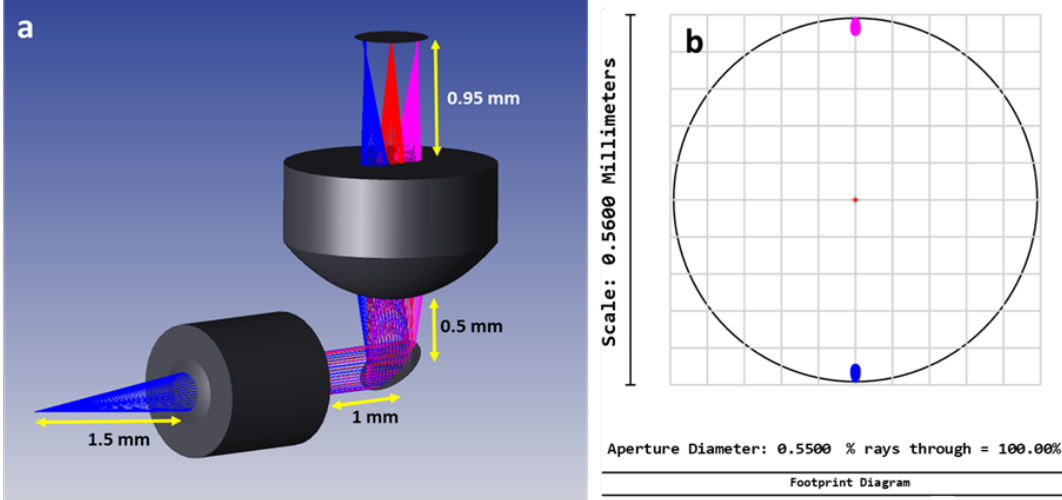
Figure 1. ( a ) Zemax shaded model of the probe design. ( b ) Footprint diagram of the tracked beam at the exit of the focusing lens.